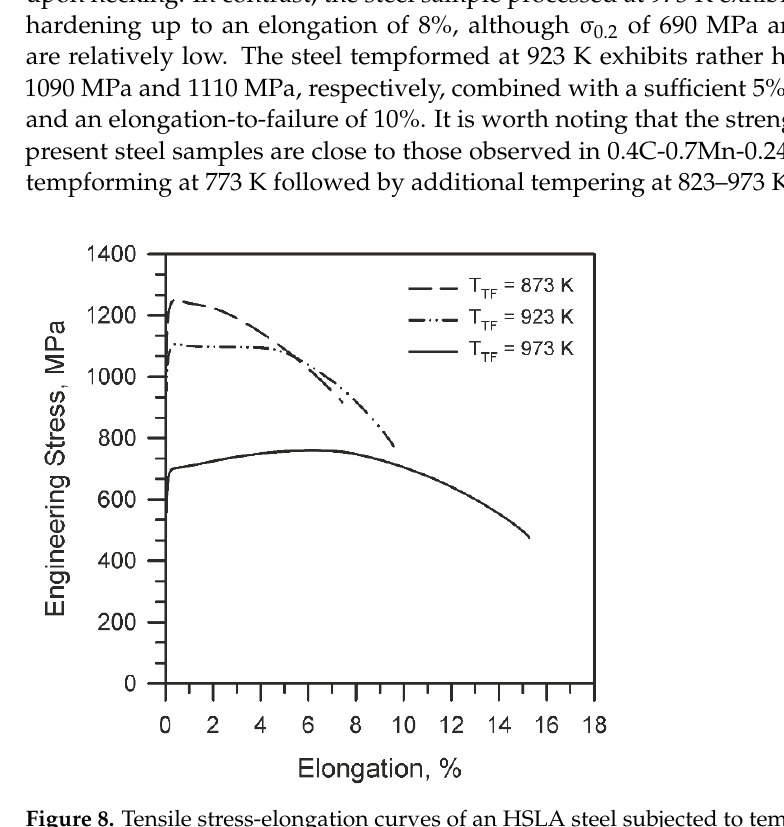
Figure 8. Tensile stress-elongation curves of an HSLA steel subjected to tempforming at indicated temperatures (T TF ). Table 2. Yield strength, UTS and total elongation after tempforming at different temperatures.